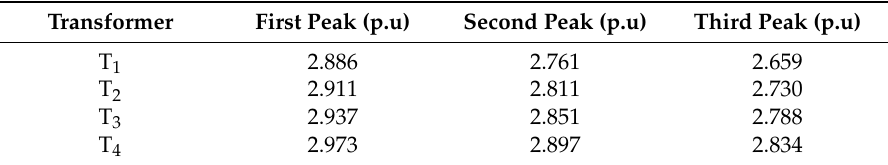
Table 3. Comparison of maximum inrush current for different load